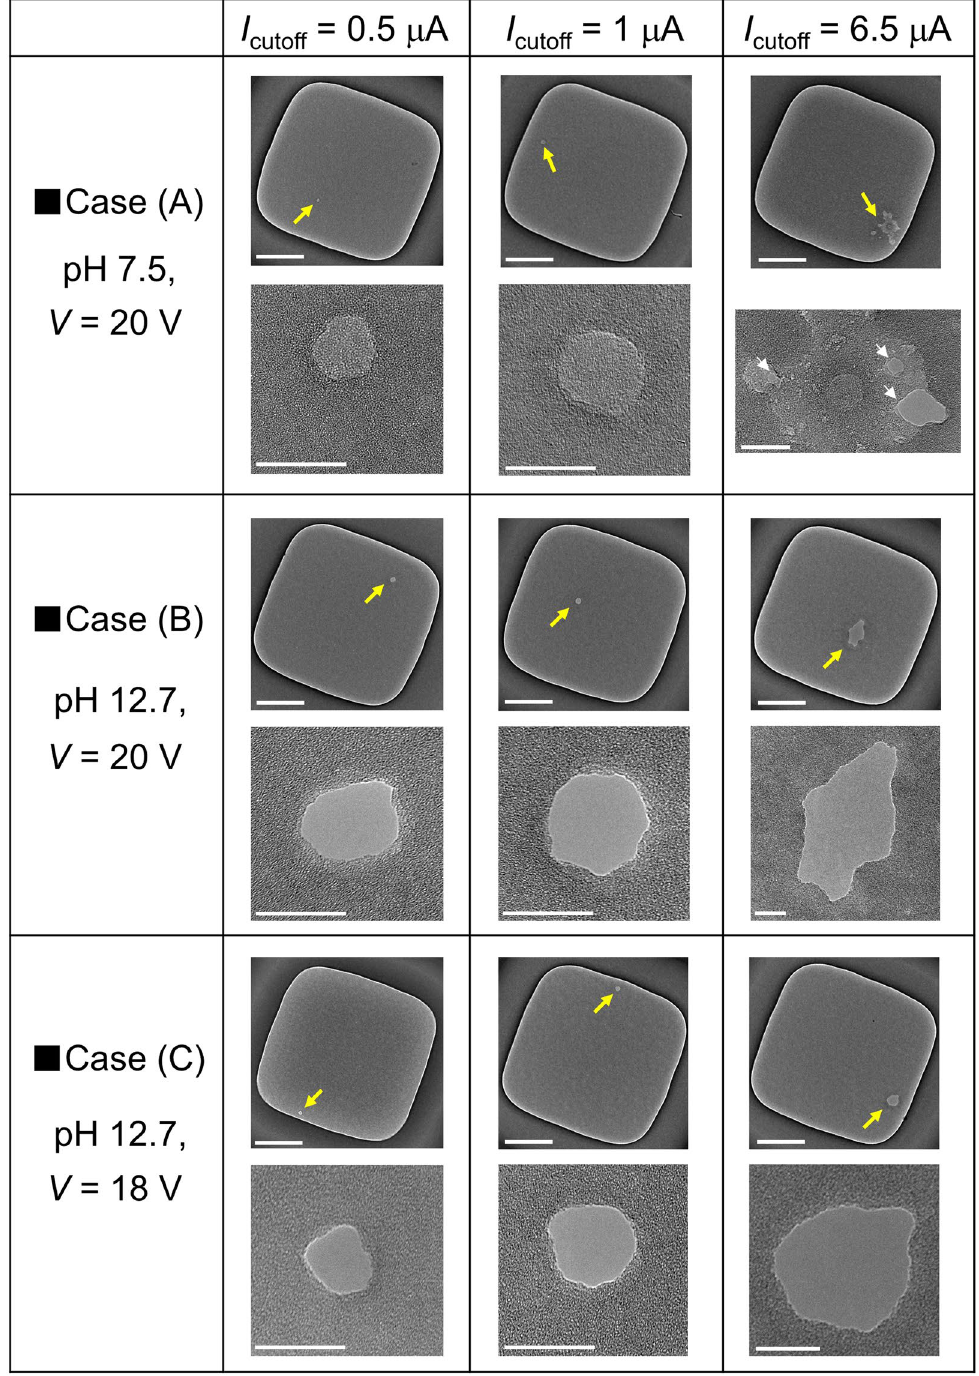
Figure 4. TEM images of SiN membranes after CBD under several pH, voltage, and I cutoff conditions. An image of the entire membrane and a magnified view of the area around the created defect or nanopore are shown in each image set. Defective portions or nanopores are indicated by yellow arrows. The thickness of the SiN membranes was 20 nm. During CBD, V cis was set at 20 V or 18 V, and V trans was set at 0 V. Scale bars for the images of the entire membranes are 200 nm, and those for the magnified views are 20